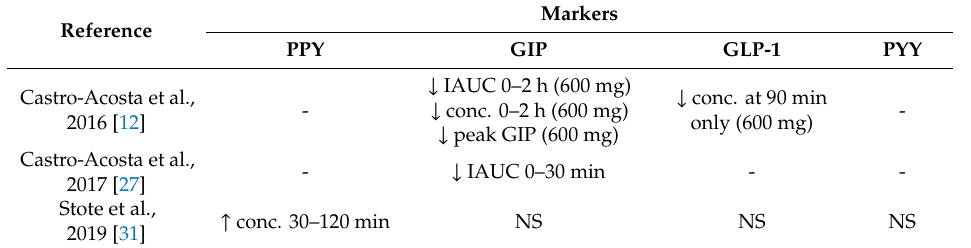
Table 5. E ff ects of anthocyanin intake in composite meals on incretin